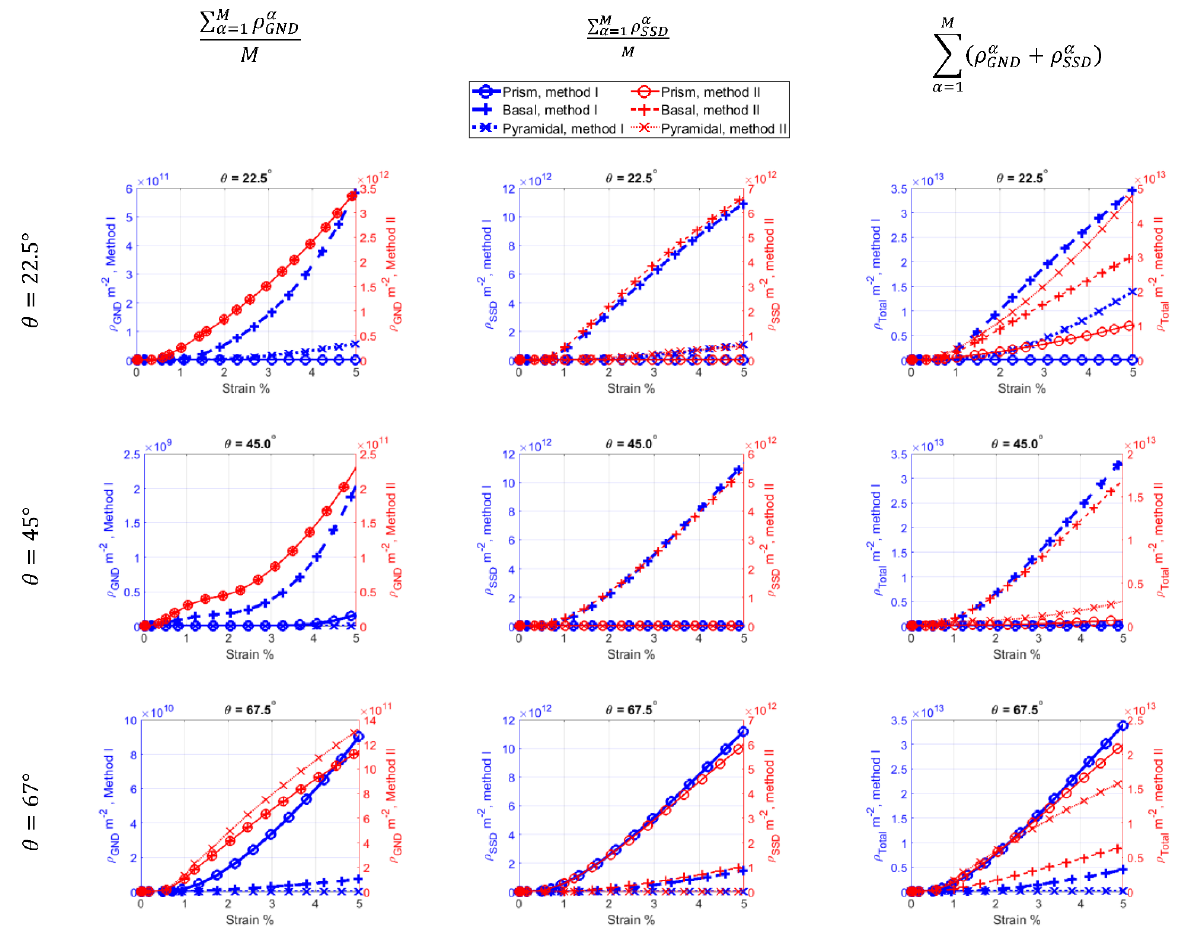
Figure 4. The evolution of the average GND density, average SSD density, and total dislocation density of prism, basal and pyramidal slip systems at different crystal c-axis misorientations with the loading direction ( θ ). Results are for CPFE model using Method I and II. M is 3, 3, and 12 for prism, basal, and pyramidal slip systems.